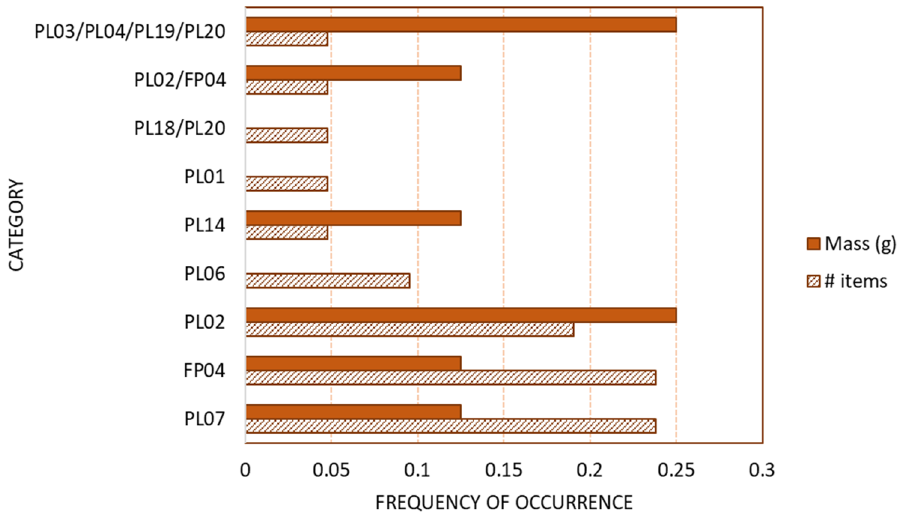
Figure 5. The most frequent categories of litter are shown according to mass and number of items. The category codes follow the standards of UNEP/IOC Guidelines on Survey and Monitoring of Marine Litter [38] (Table